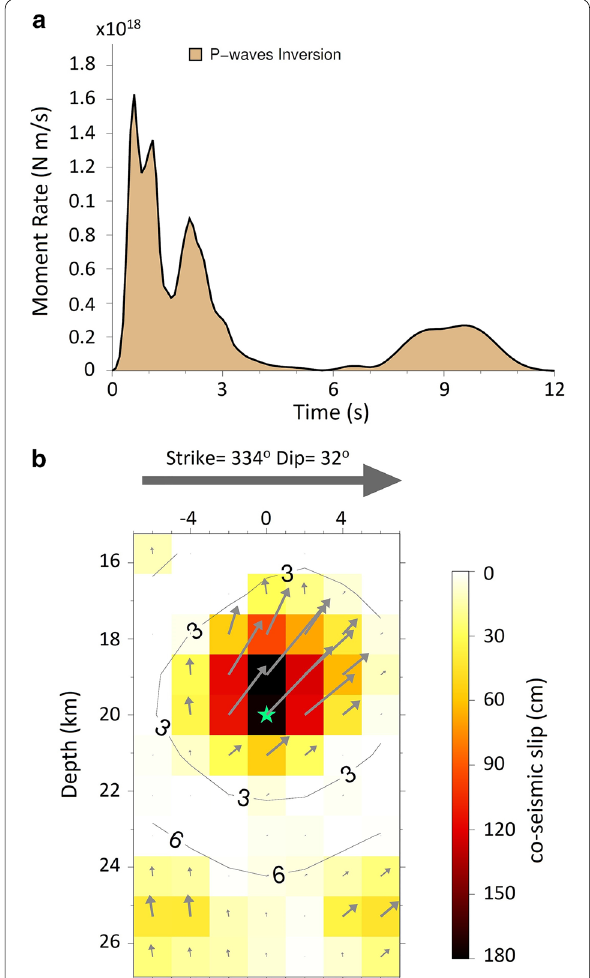
Fig. 4 a Moment rate function and b slip distribution, of the Mw 6.2 Mamuju–Majene mainshock. The gray arrows indicate the slip (rake) direction while the numbers (e.g., 3) indicate the rupture propagation time in seconds. The color represents the co-seismic slip in